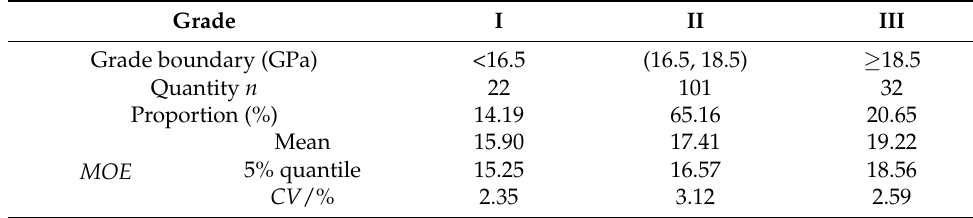
Table 1. Classification results of P. edulis bamboo.